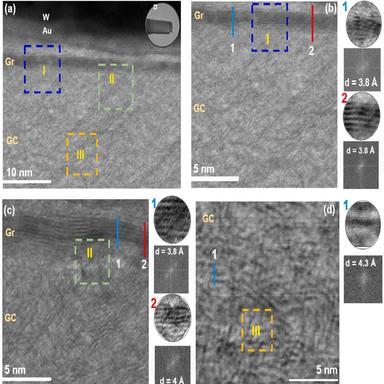
(a) GrGC sample prepared by FIB for STEM imaging. (b) STEM image of GrGC FIB at ROI I (c) and (d) STEM images at ROI II and III, respectively. Insets show Fast Fourier Transform (FFT) carried out at the three ROIs to determine their respective interlayer distances between stacked Gr layers. (A colour version of this figure can be viewed online.)